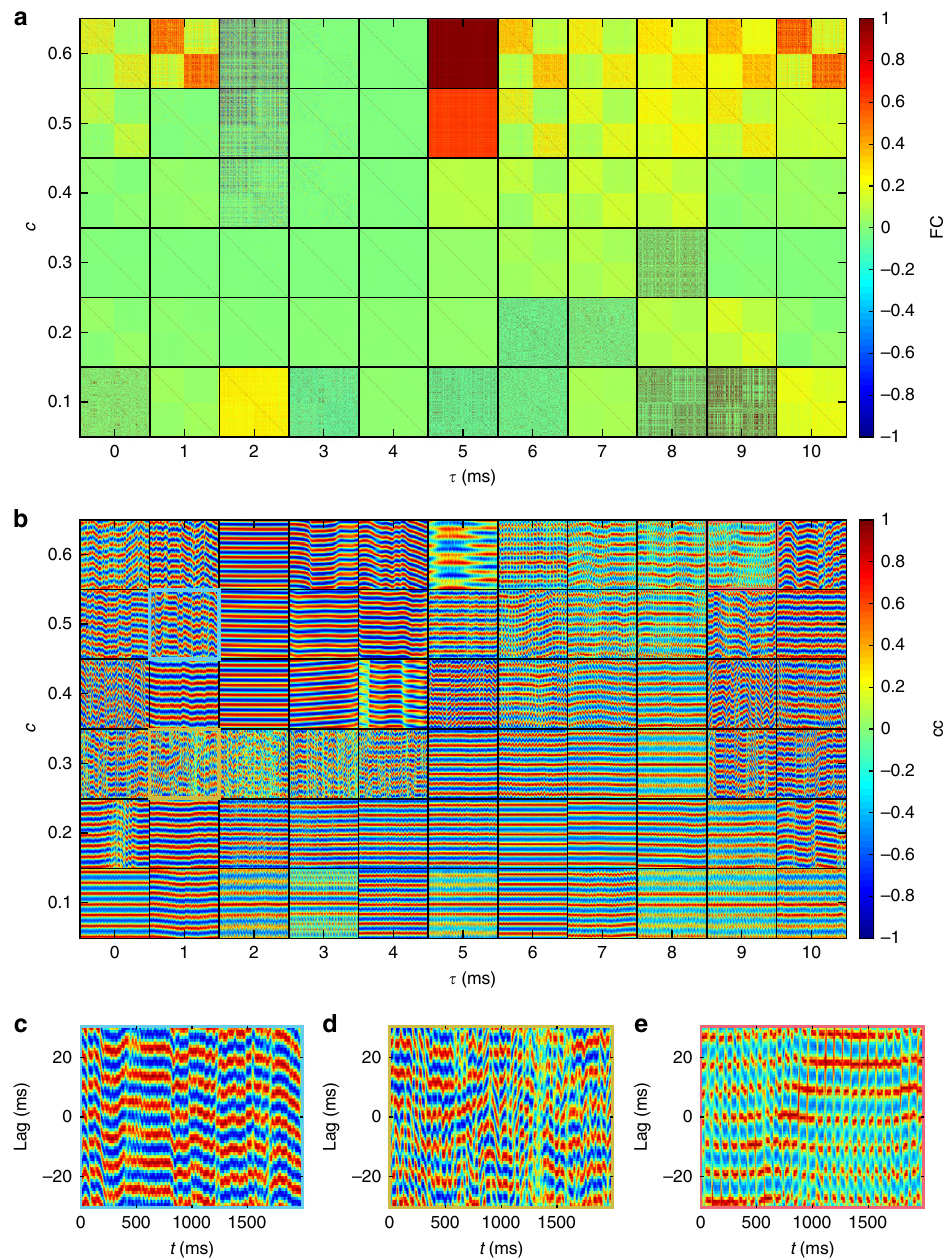
Fig. 8 Dynamics as a function of coupling strength c and delay τ . a Functional connectivity matrices calculated directly from the neuronal time series (corresponding results after convolution of the neuronal time series with a hemodynamic response function are provided in Supplementary Fig. 4). Each tile shows one FC matrix with axes indexing the nodes 1 – 513. b Interhemispheric cross-correlation functions, showing a 1 s segment (time is on the horizontal axis in each tile) for lags between − 30 ms and 30 ms (lag is on the vertical axis in each tile). Exemplars in the text are highlighted here with colored outlines and shown in corresponding panels: c weakly coherent waves; d interhemispheric cross-correlation dynamics despite negligible average FC; and e lurching